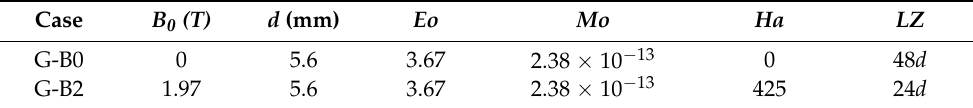
Table 3. Simulation cases for the grid dependency study.